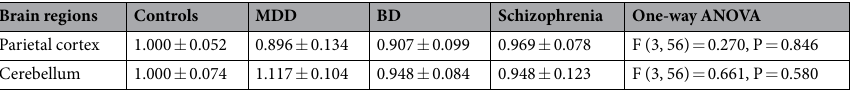
Table 3. Expression of SVC2 in the parietal cortex and cerebellum from psychiatric disorders. The data are the mean ± S.D. (N = 15). MDD: Major depressive disorder, BD: Bipolar disorder. The values were shown as the ration of SVCT2 to β